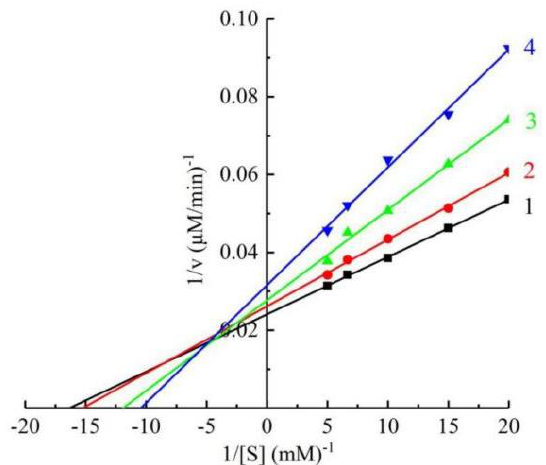
Figure 3. Kinetic parameters of mushroom tyrosinase inhibition by Q1. Concentrations of Q1 for curves 1 – 4 were 0, 15, 60, 120 µM.